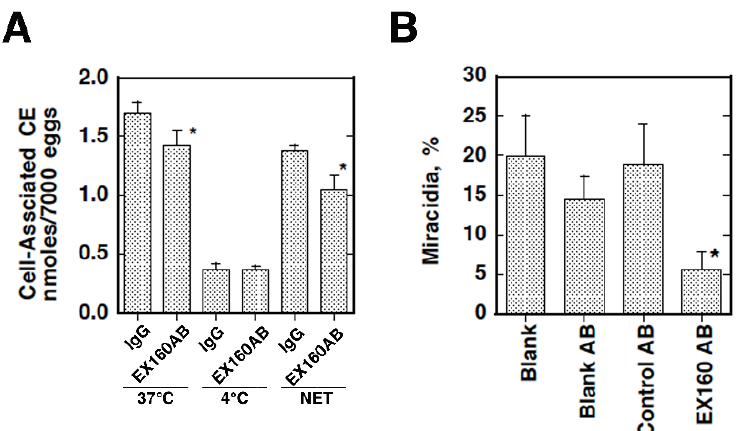
Figure 6. Suppression of cholesteryl acylester (CE) uptake (A) and embryonation of the S. japonicum eggs (B) by the antibody raised against the extracellular domain peptide representing the residues 249–408 of CD36RP. Blank AB, nonimmunized rabbit antibody, Control AB, antibody against the intracellular domain of CD36RP (residues 331–348)